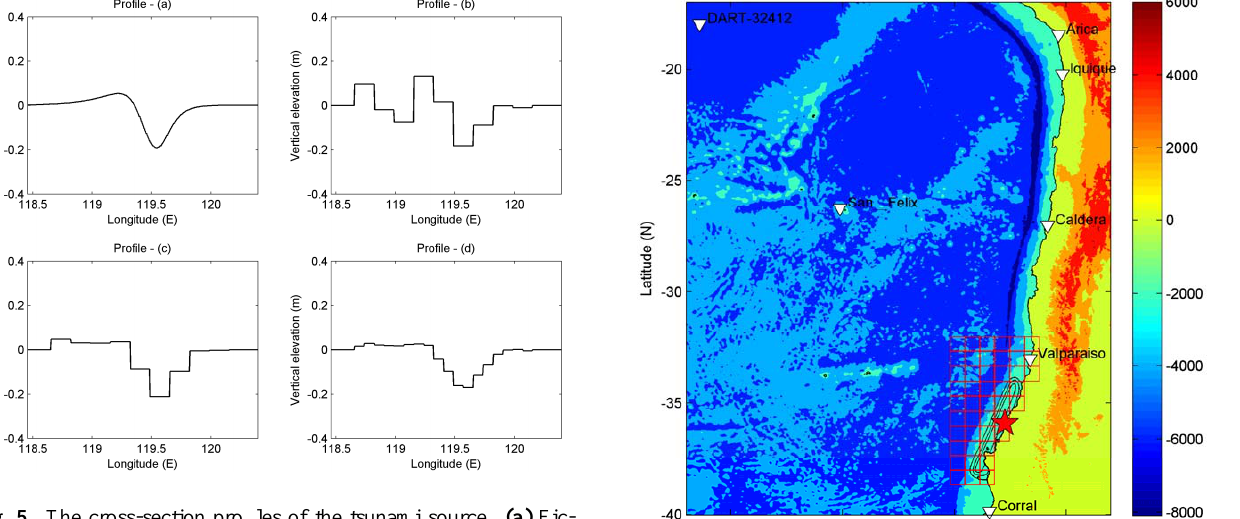
Fig. 5. The cross-section profiles of the tsunami source. (a) Fic- Figure 5. The cross-section profiles of the tsunami source. (a) Fictitious tsunami source. (b) 3 titious tsunami source. (b) by Least square inversion. (c) with by Least square inversion. (c) with smoothing constraint. (d) with smoothing constraint and 4 smoothing constraint. (d) with smoothing constraint and GSM. GSM. 5